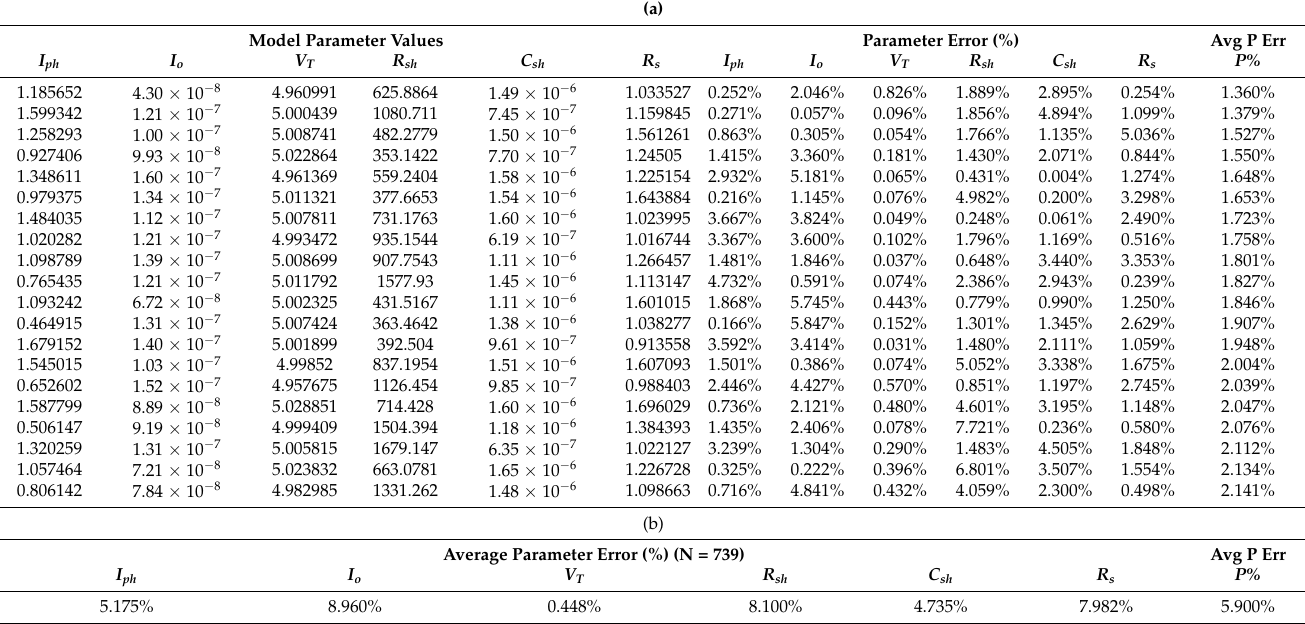
Table 2. ANN + NCP (Input 100, V[0] . . . V[49], i[0] . . . i[49], three hidden layers, 1st hidden layer 200 nodes, 2nd hidden layer 150 nodes, 3rd hidden layer 50, output 6 model parameters values, learning of the model parameters (first 20 sorted data samples). ( b ) Summary of average estimation error of the model parameters for testing